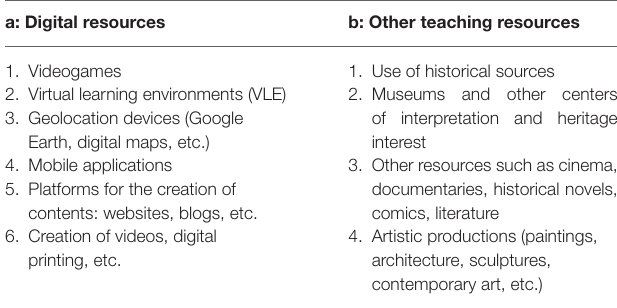
TABLE 5 | Sub-groups 3rd